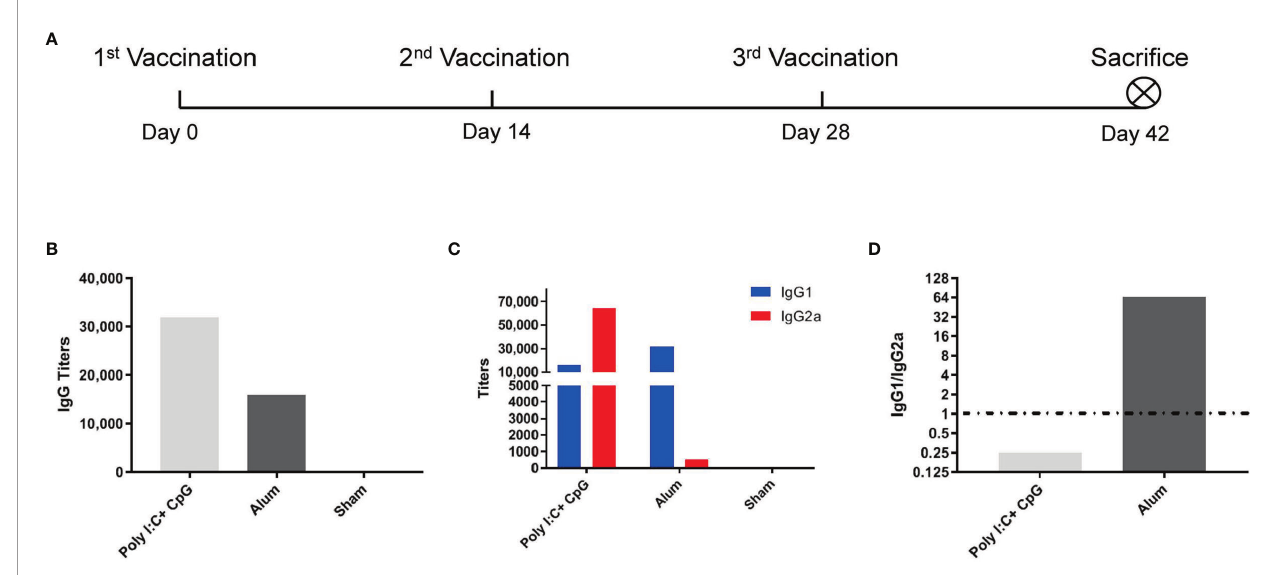
FIGURE 1 | Alum induced a Th2-oriented immune response, whereas nucleic acids induced a Th1-oriented response when adjuvanted with the S1 protein. (A) Immunization schedule, N=6 in each group; (B) S1-speci fi c IgG titers of immune serum; (C) S1-speci fi c IgG1 and IgG2a titers in immune serum; (D) IgG1/IgG2a ratio of immune serum. All of the above titers were detected in pooled serum from each immunized group, and the means and standard deviations of duplicates are